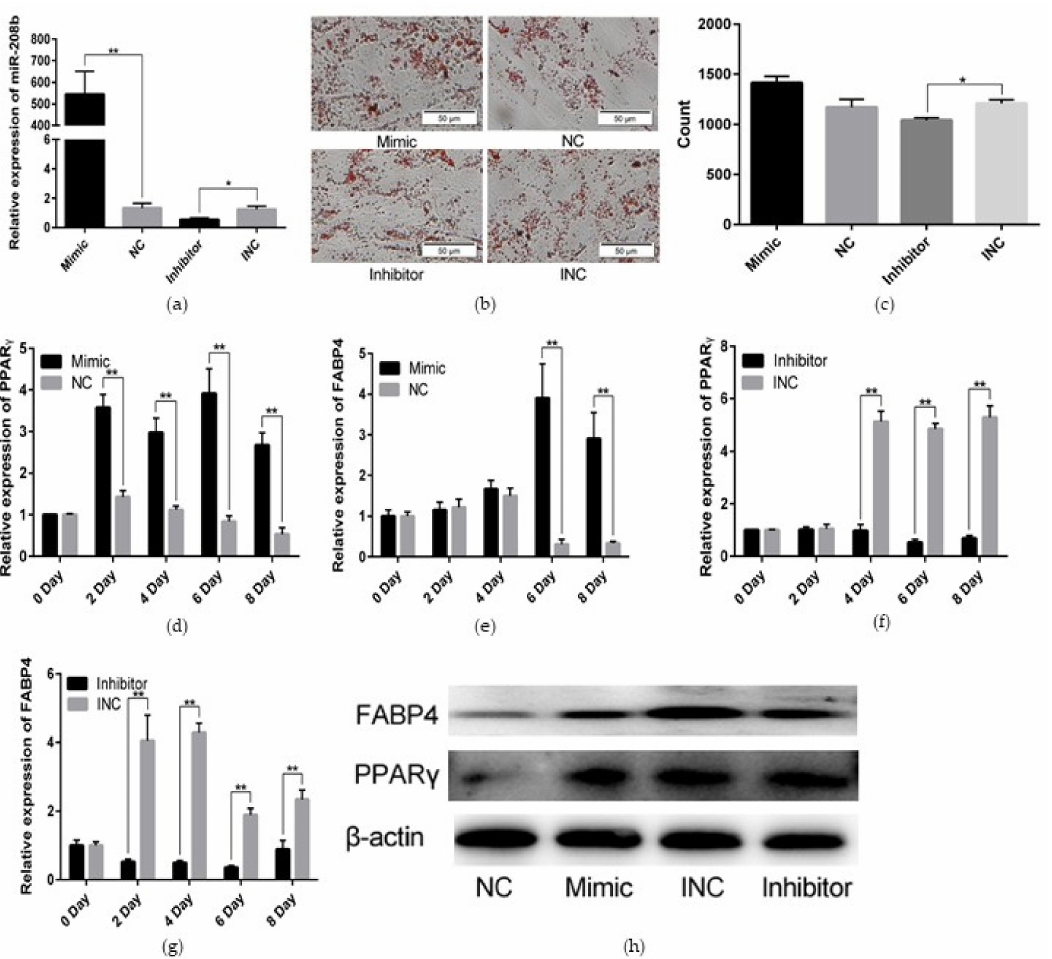
Figure 2. miR-208b promotes rabbit preadipocyte differentiation. ( a ) Transfection efficiency detection of miR-208b mimic and miR-208b inhibitor. ( b ) Oil Red O staining of lipid droplets after 8 days of transfection. ( c ) The number of lipid droplets ( n = 3) after 8 days of transfection. ( d , e ) The relative expression levels of PPAR γ and FABP4 in rabbit preadipocyte induced differentiation at 0, 2, 4, 6, and 8 days after transfecting with miR-208b mimic and NC. ( f , g ) The relative expression levels of PPAR γ and FABP4 in rabbit preadipocyte induced differentiation at 0, 2, 4, 6, and 8 days after transfecting with miR-208b inhibitor and INC. ( h ) PPAR γ and FABP4 protein levels during preadipocyte differentiation after transfecting with NC, miR-208b mimic, INC, and miR-208b inhibitor. The data are presented as means ± SEM ( n = 9). * p < 0.05; ** p <